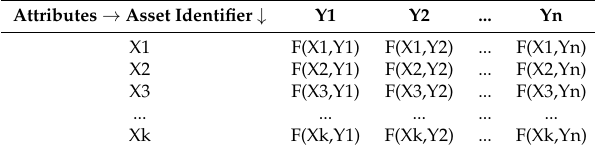
Table 1. List of Critical Group Attributes.